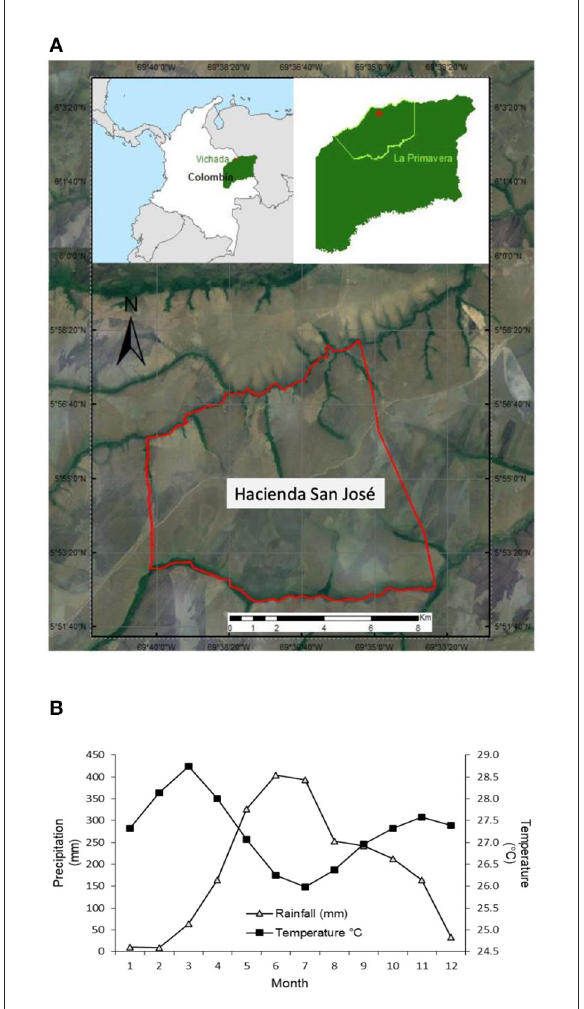
FIGURE1 (A) Location of Hacienda San Jose (HSJ) and aerial view of the experimental area at HSJ and (B) historical climate (temperature and rainfall) pattern in the La Primavera municipality (IDEAM,